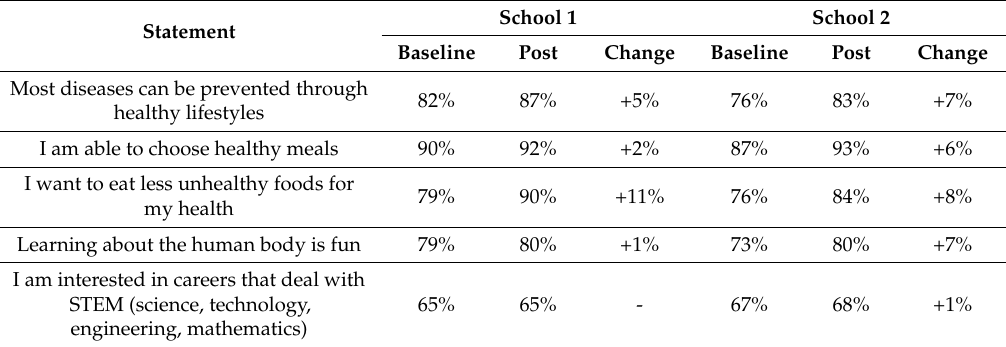
Table 2. Student perception and attitudes change from baseline to post intervention at school 1 and school 2. School 1 School 2 Statement Baseline Post Change Baseline Post